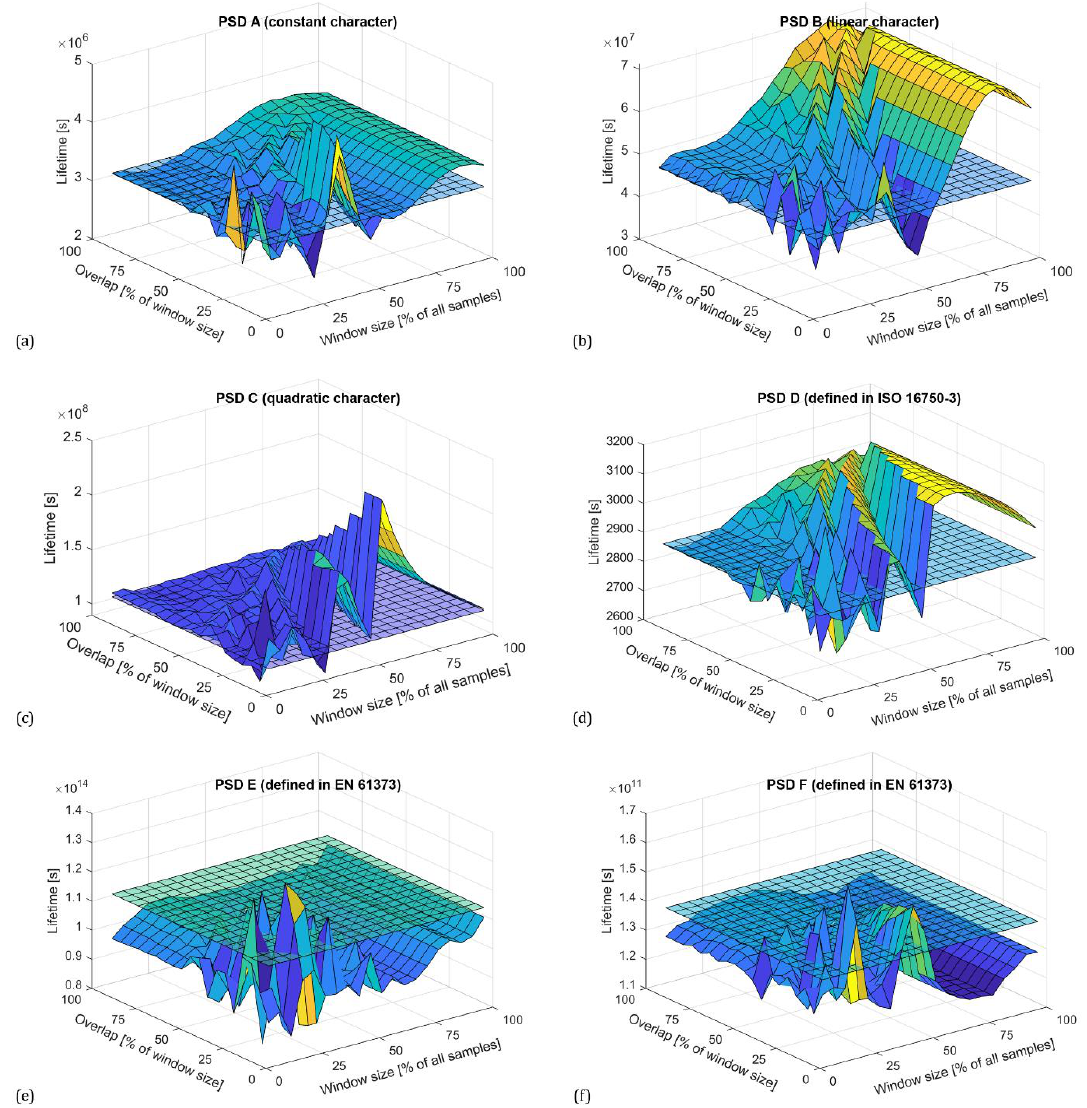
Figure 9. Fatigue life estimates determined by Dirlik probability model (Hamming window).